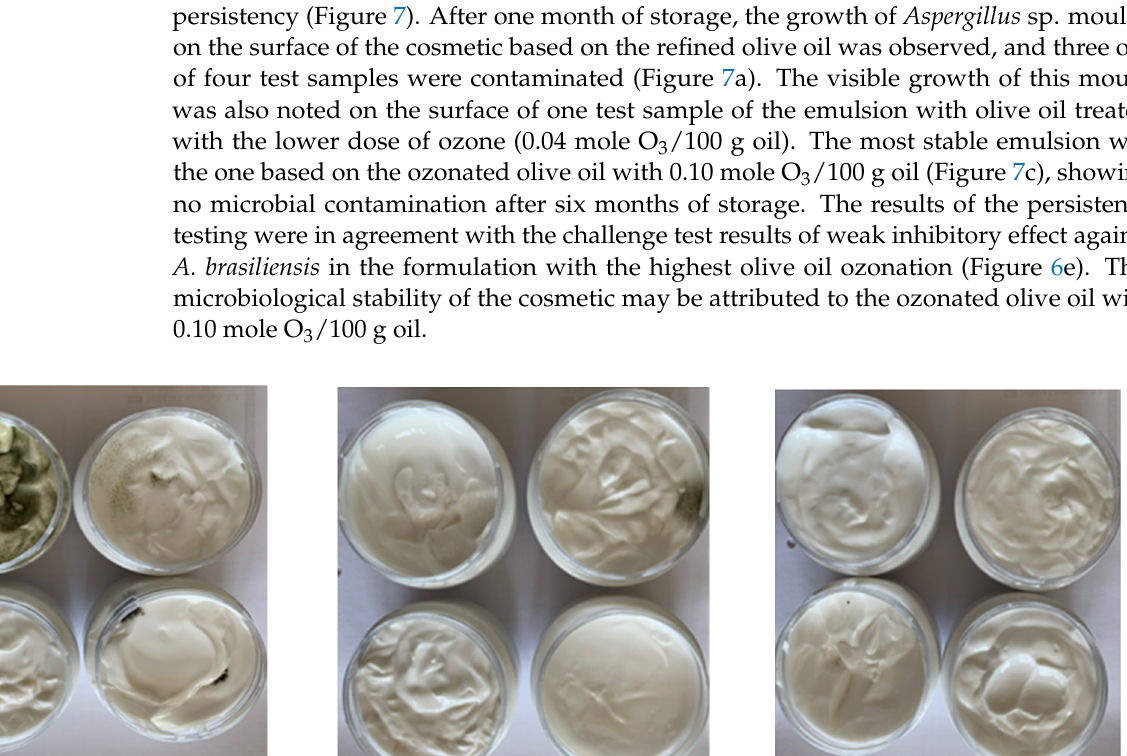
Figure 6. Inhibition of microorganisms growth in cosmetic emulsions with refined olive oil (continued line), ozonated olive oil 0.04 mole O 3 /100 g oil (discontinued line), ozonated olive oil 0.10 mole O 3 /100 g oil (dotted line): ( a ) E. coli ; ( b ) P. aeruginosa ; ( c ) S. aureus ; ( d ) C. albicans ; ( e ) A. brasiliensis ; * marks statistically significant differences ( p < 0.05). 2.8. Persistency of Cosmetic Emulsions